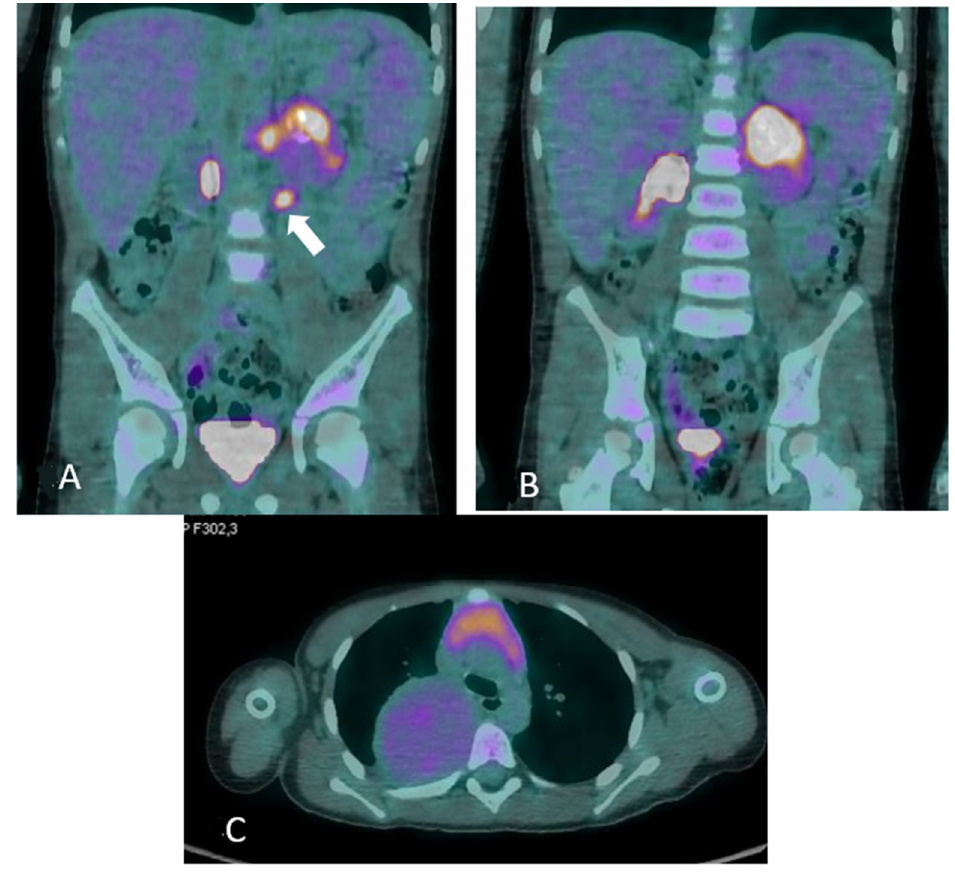
Figure 4. 18 F ‐ fluorodeoxyglucose/computed tomography ( 18 F ‐ FDG PET/CT) at one year from diagnosis. The patient was in good general clinical condition and the disease was stable; however, there were critical issues that were determined by the inability to rule out a nodular component within the already biopsied thoracic mass or the unstudied abdominal mass (see Figure 7). In order to characterize the metabolic activity of the mass, a 18 F ‐ FDG PET/CT scan was performed and showed FDG uptake in the left paravertebral mass ( A ) (maximum standardized uptake value ‐ SUVmax ‐ 6.0), in the para ‐ aortic lymph nodes ( B ) (maximum size 1.2 cm, SUVmax 5.8) and in the thoracic mass ( C ) (SUVmax2.3); no tracer uptake was detected in other sites. Tumor markers remained stable and within normal limits at all evaluations. The radiological and metabolic features assessed by 18 F ‐ FDG PET have not allowed the nature of the lesions to be clearly defined; in particular, with the available radiological investigations, the differentiation of benign and malignant NTs is quite controversial so far. Nevertheless, the different FDG uptake of abdominal lesions with lymph node involvements suggests a nodular component. In addition, the biopsy performed at onset may have been unrepresentative of the whole tumor, leading to late misdiagnosis with significant clinical fallout.